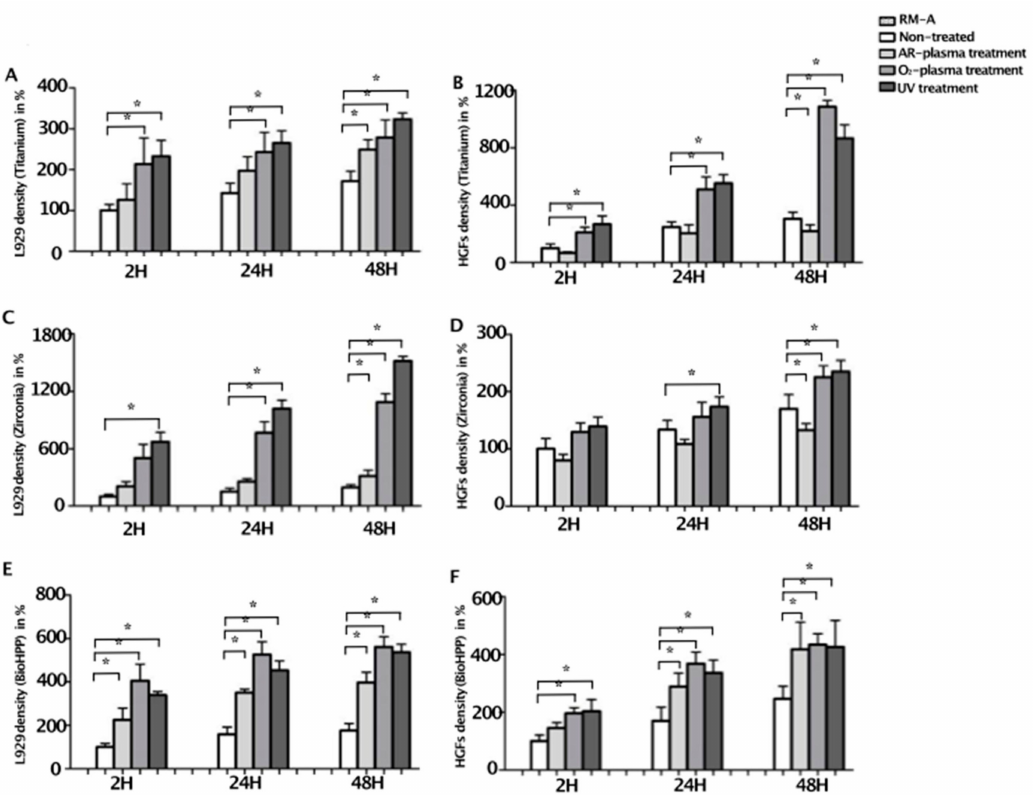
Figure 2. The number of living cells attached to di ff erent surface-treated titanium, zirconia and BioHPP, after 2, 24 and 48 h. The number of living cells attached to controls and surface treated titanium ( A , B ), zirconia ( C , D ) and BioHPP ( E , F ) was counted after 2, 24 and 48 h of incubation using live–dead staining. After 2 h of incubation, only a small number of cells adhered to the surfaces of the three materials in the control groups. During 48 h of incubation, the number of cells increased steadily. Generally, compared to controls, a significantly larger number of cells attached after oxygen plasma of UV light treatment on all disks and, additionally, after argon plasma treatment on BioHPP disks. For better visualization, results are shown in percent of 2 h negative controls ± standard deviation, * p <